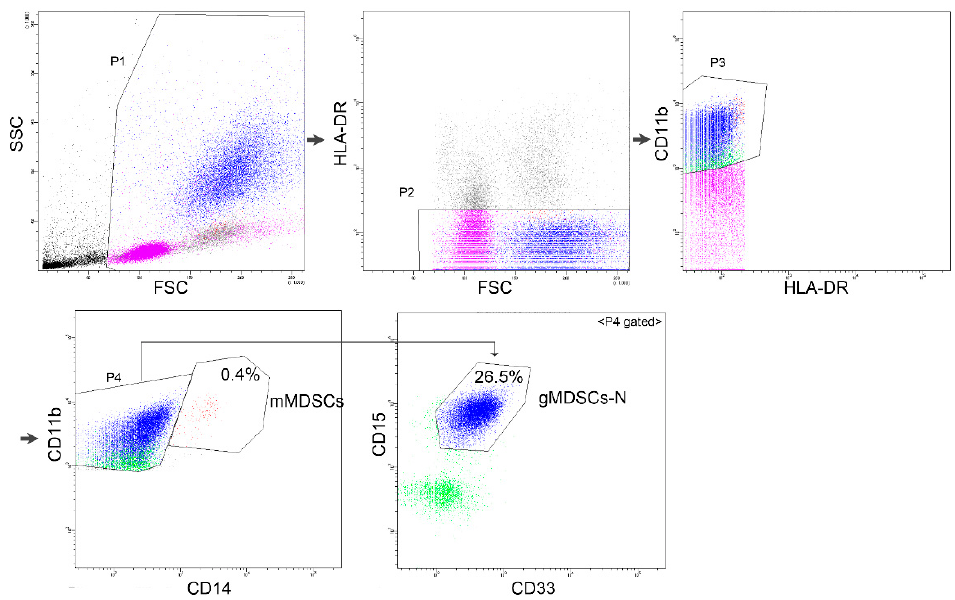
Figure 1. Gating strategy for myeloid-derived suppressor cells in peripheral blood. Monocytic MDSCs are defined as leukocytes of CD11b + HLA-DR − /low CD14 + immunophenotype and granulocytic MDSCs-N as CD11b + HLA-DR − /low CD14 − CD33 + CD15 + immunophenotype. Abbreviations: SSC, side scatter; FSC, forward scatter; HLA-DR, human leukocyte antigen-DR; mMDSCs, monocytic myeloid-derived suppressor cells; gMDSCs-N, granulocytic myeloid-derived suppressor cells with neu- trophils.